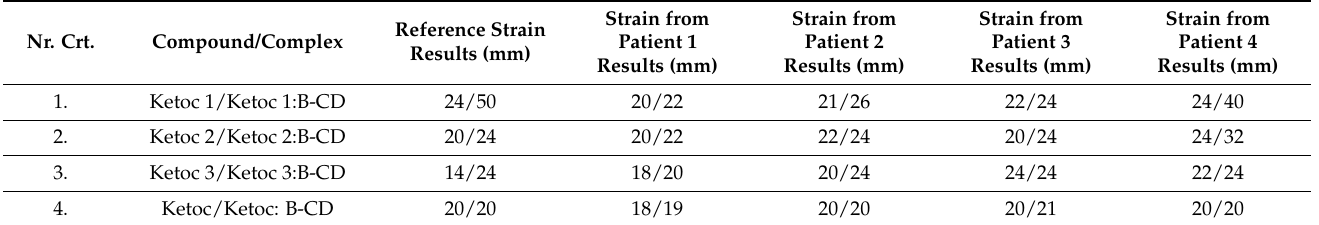
Table 2. Antifungal activity evaluation of ketoconazole vs. new compounds (free and complexed forms).